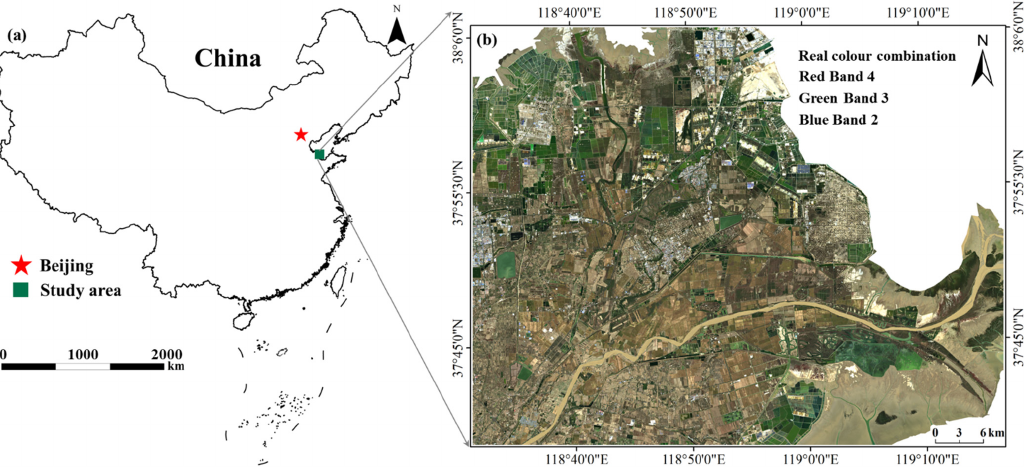
Figure 1. The ( a ) spatial location and ( b ) real colour Landsat 8 OLI image of the study